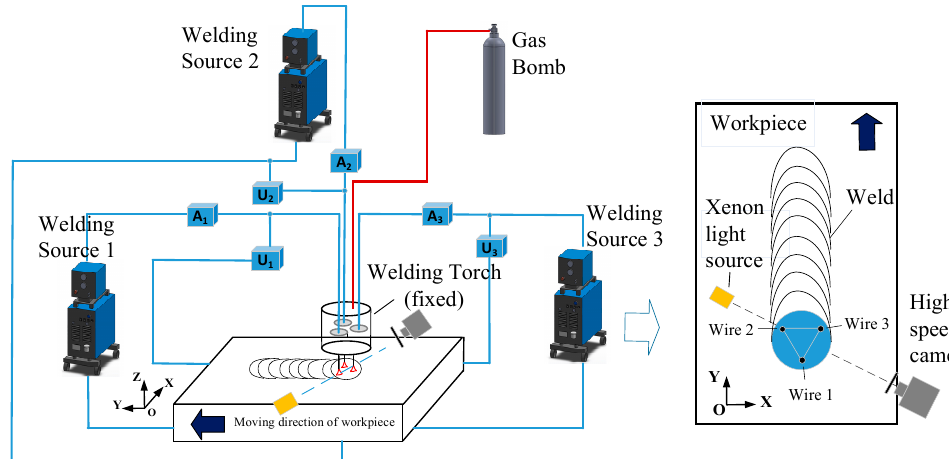
Figure 1. Schematic diagram of the experimental system.